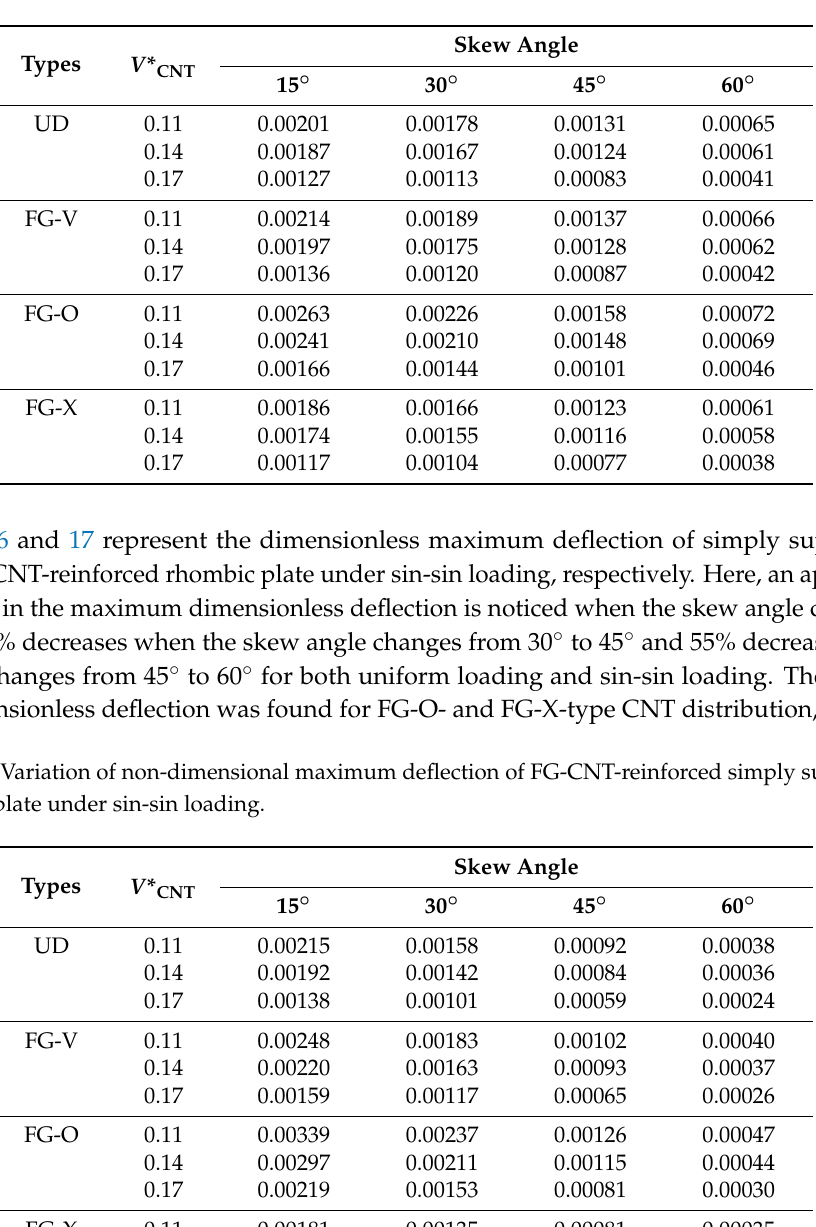
Table 15. Variation of non-dimensional maximum deflection of FG-CNT-reinforced clamped rhombic plate under uniform